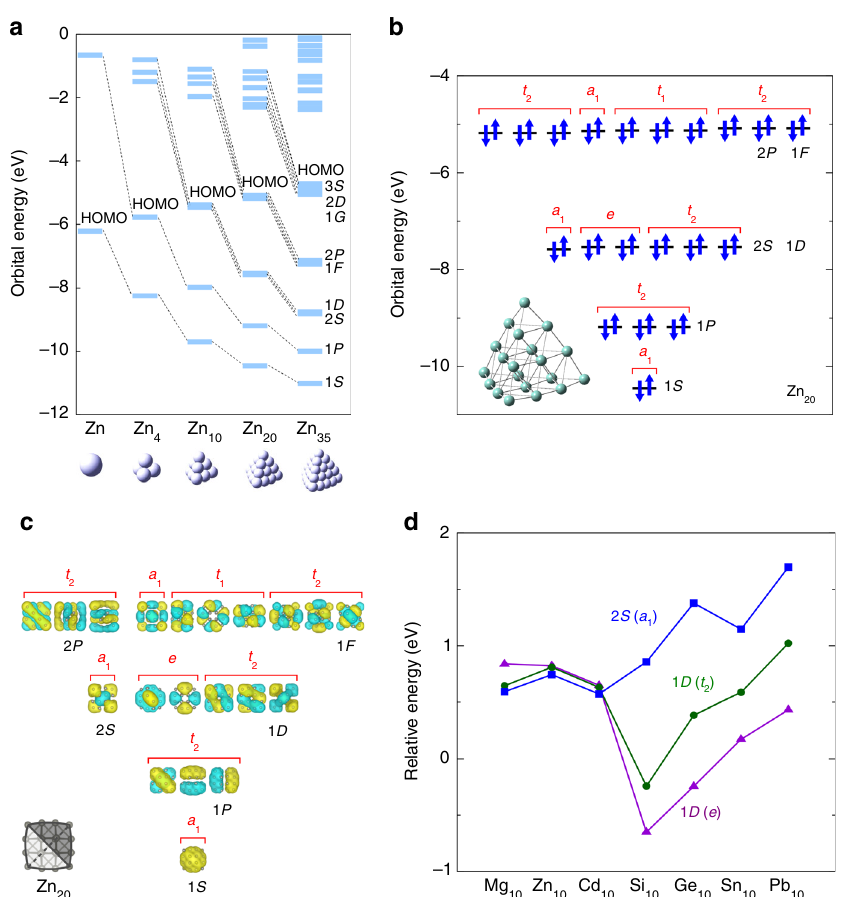
Fig. 1 DFT calculations of tetrahedral clusters. a Molecular orbital levels of Zn 1 , Zn 4 , Zn 10 , Zn 20 , and Zn 35 . Zn 35 favors a lower symmetry but was constrained to have T d symmetry for comparison purposes. b Occupied molecular orbital levels of Zn 20 with their irreducible representations and the optimized geometry. c Molecular orbitals of Zn 20 , the isosurface values of which are 1.0 × 10 − 2 a.u. d 2 S and 1 D molecular orbital levels of Mg 10 , Zn 10 , Cd 10 , Si 10 , Ge 10 , Sn 10 , and Pb 10 . The molecular orbital levels of each cluster have been shifted such that they originate at the atomic orbital level of the constitutive element. All the above calculations were carried out at the B3LYP/LanL2DZ level of theory implemented in Gaussian 09, Rev. E.01